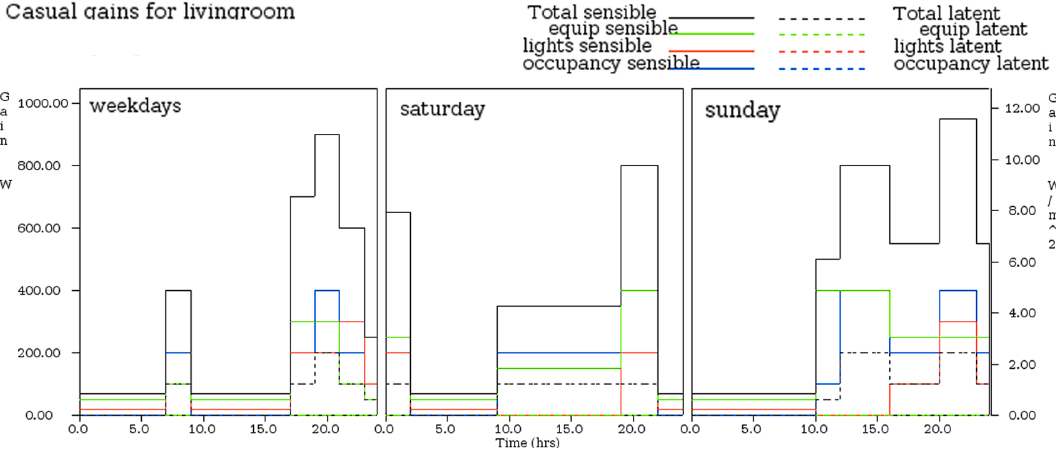
Figure 6. Building model in ESP-r: living room casual heat